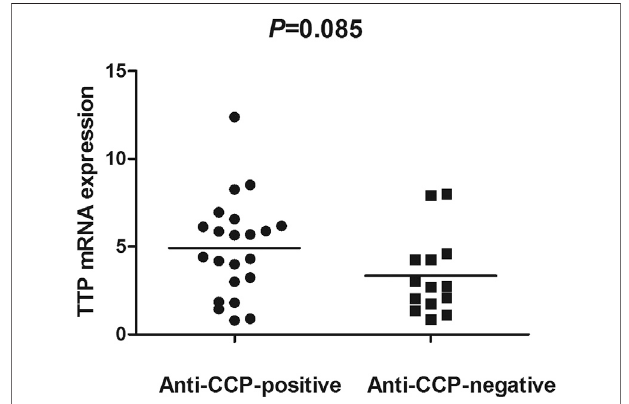
FIGURE 4 | Comparision of TTP mRNA expression level in PBMCs between anti-CCP-positive RA patients and anti-CCP-negative RA patients.